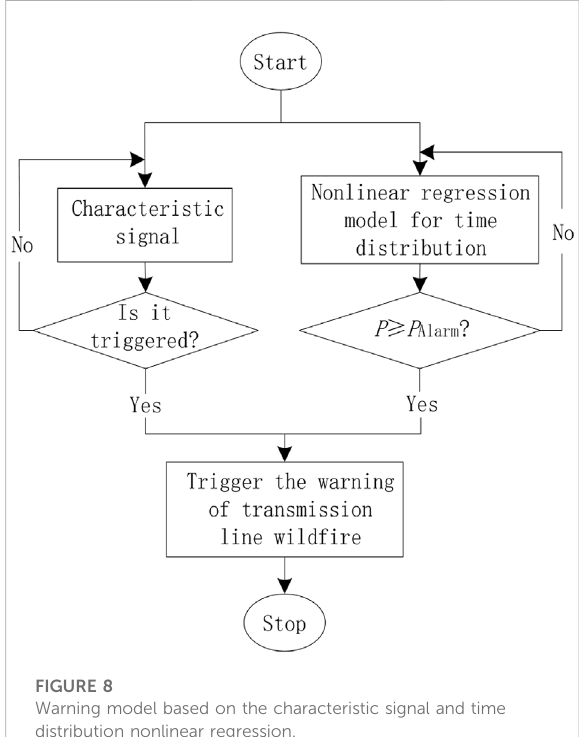
FIGURE 8 Warning model based on the characteristic signal and time distribution nonlinear